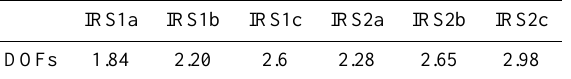
Table 7. Vertical information expressed in DOFs of the CO re- trievals for each scenario.